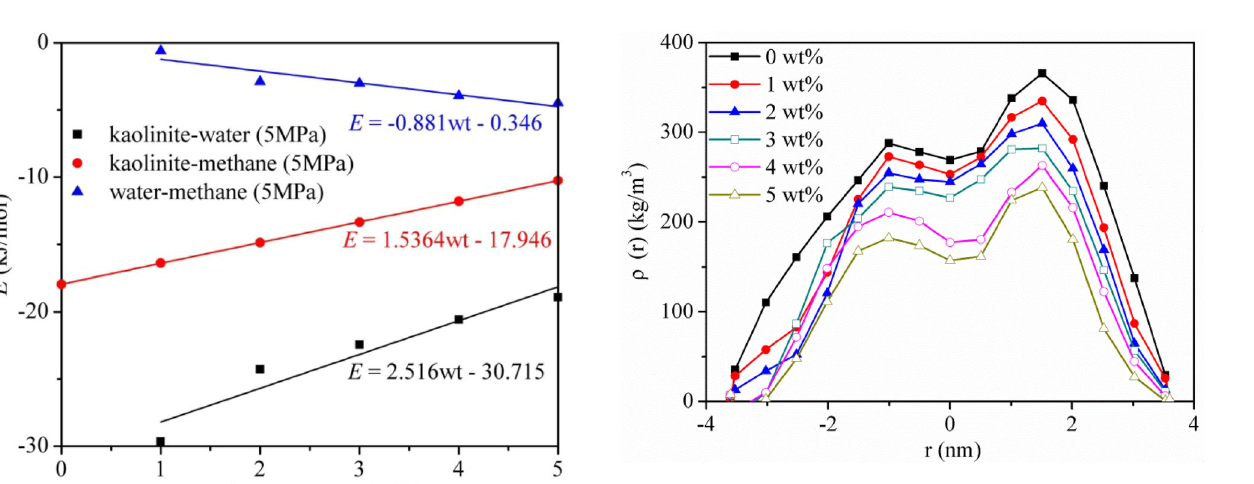
Fig. 10 Density profiles of CH 4 in kaolinite with different water content at 293.15 K and 5 MPa Table 1 The first peak values and second peak values of weight density distributions between CH 4 and kaolinite with different